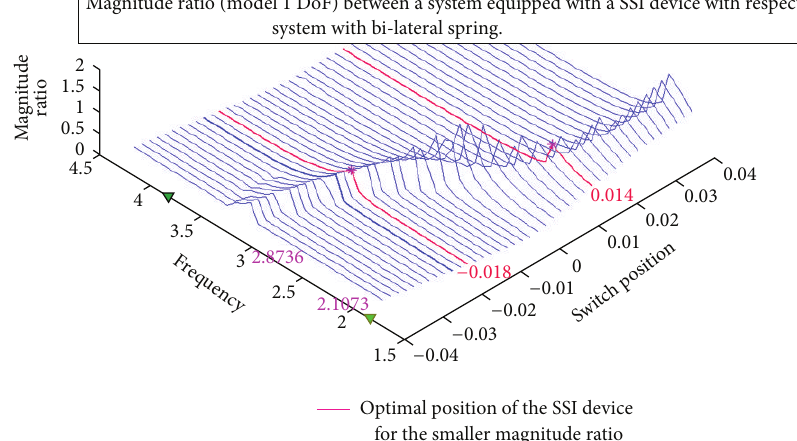
Figure 12: Detuning effect computed on a SDoF model in function of the switch position and input